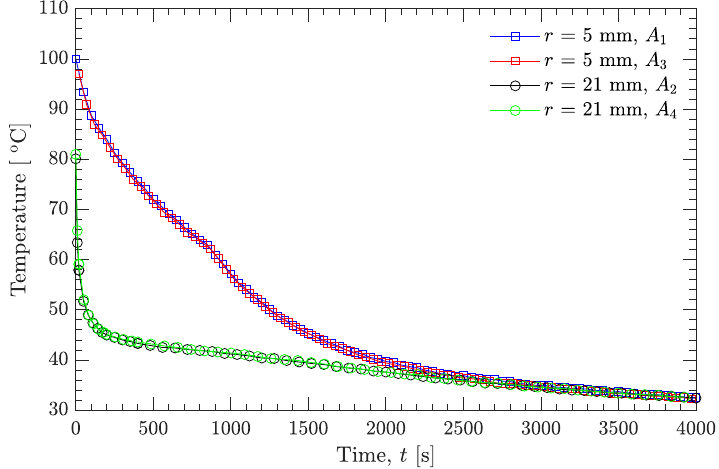
Figure 3. Experimental temperature profiles.